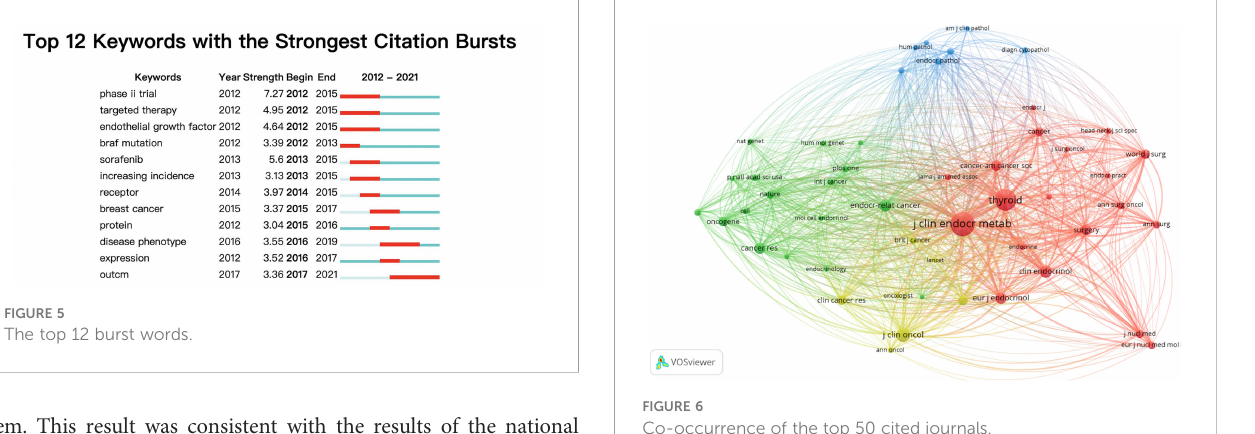
FIGURE 6 Co-occurrence of the top 50 cited